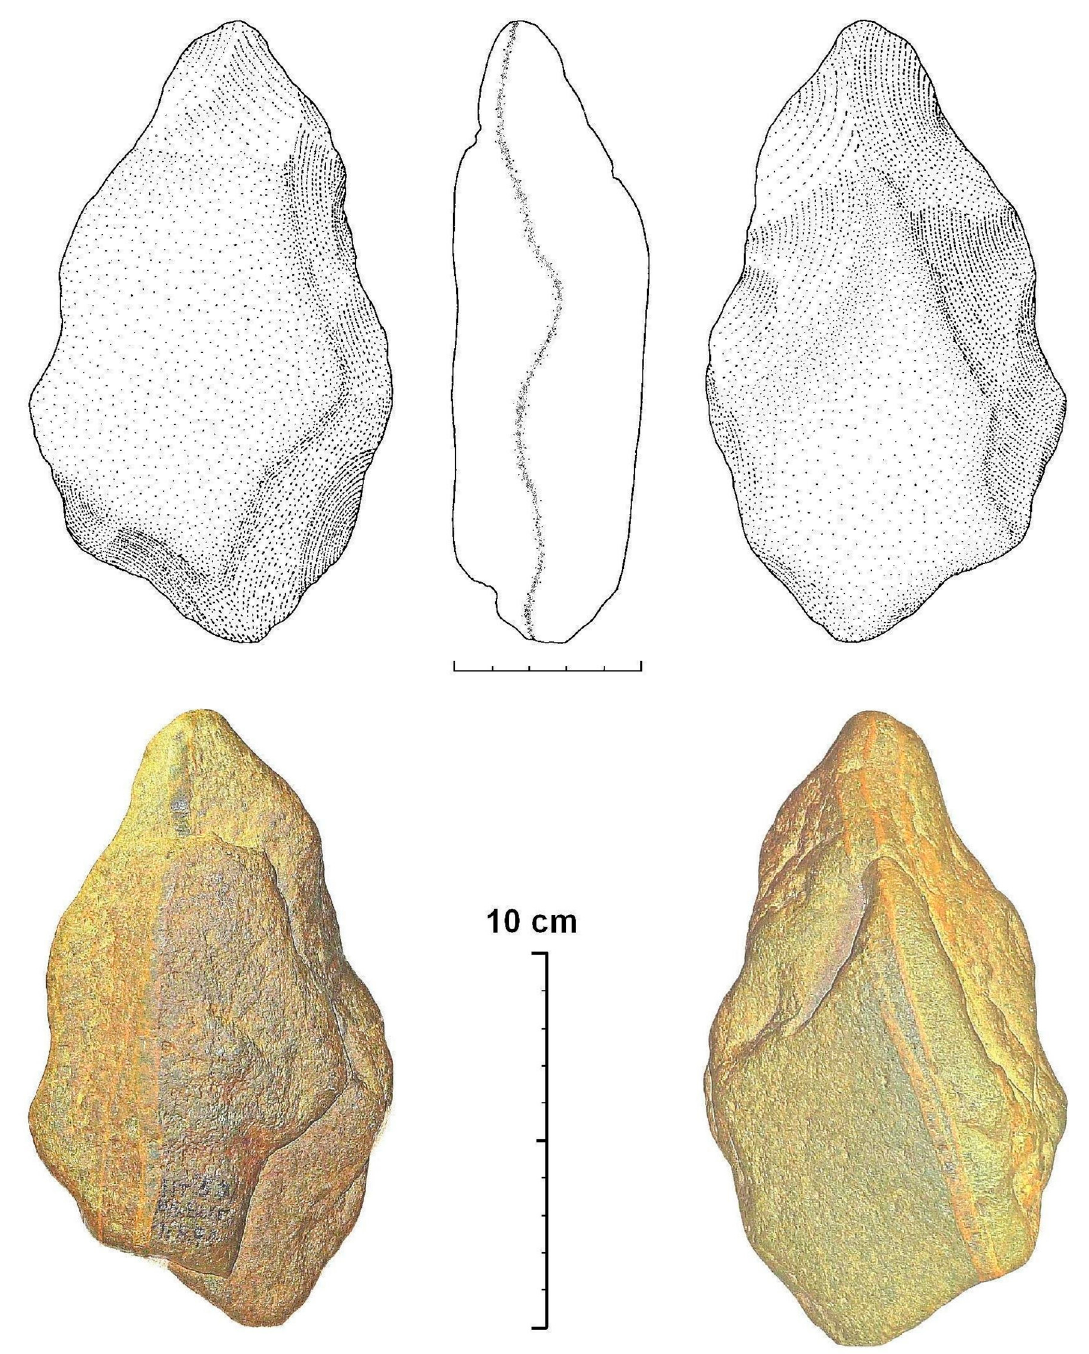
Figure 26. Dorsten-Schermbeck. Heavily rolled handaxe (quartzite) and its graphic interpretation by Beate Kaletsch. (Photo: H. Klingelhöfer.).